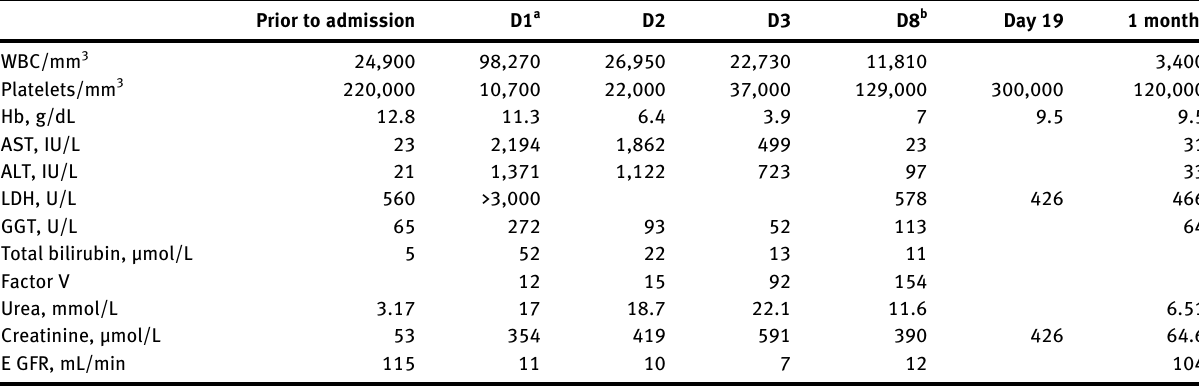
Table  : Laboratory data before, during and after